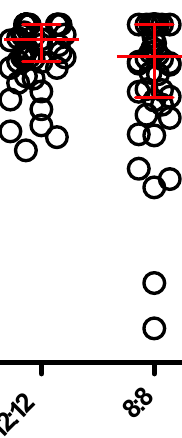
Figure 5. Relative usage of NHEJ and SSA DSB repair pathways with maternal effect and zygotic endonuclease in flies maintained under 12:12 versus 8:8 L:D. Each symbol represents the offspring of